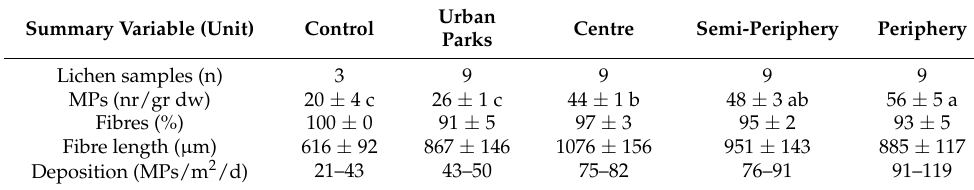
Table 1. Mean ( ± standard error) number of MPs accumulated by the fruticose lichen Evernia prunastri in each concentric zone after three months of exposure (number per gram of dry weight), along with the proportion of fibres and fibre length in each zone. Different letters indicate statistically significant differences ( p < 0.05) in MP accumulation between zones. The range of estimated deposition of MPs in each zone is also reported.